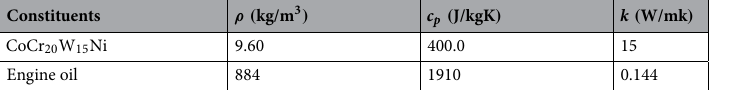
Table 2. Thermal and physical characteristics of CoCr 20 W 15 N nanoparticles and engine oil 33,34 .